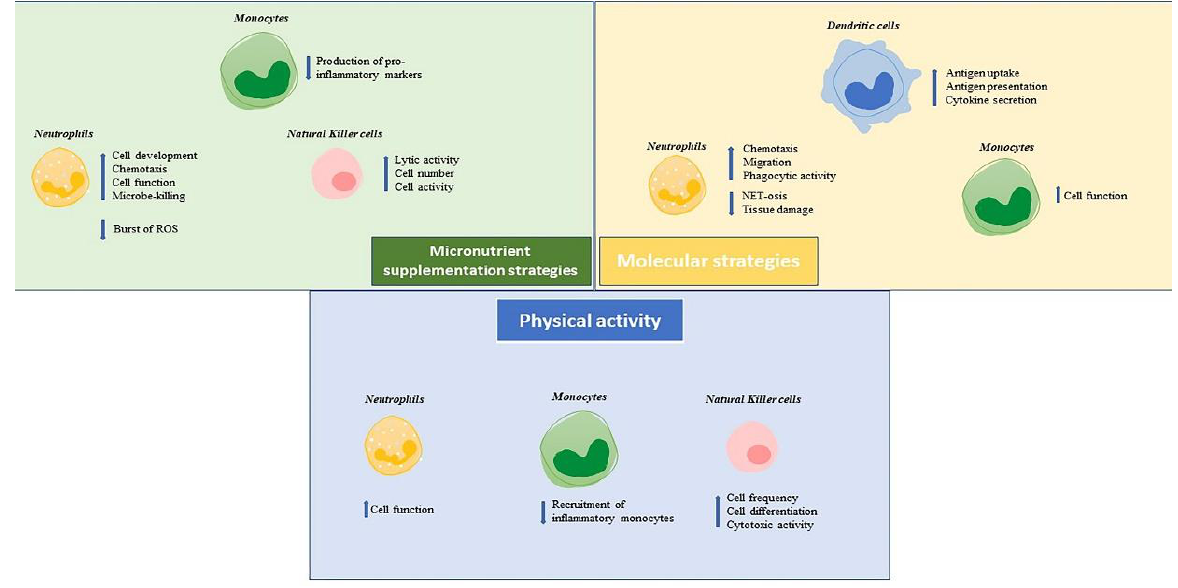
Figure 1. The figure shows how the main strategies to enhance the immune system response act on each cell of innate